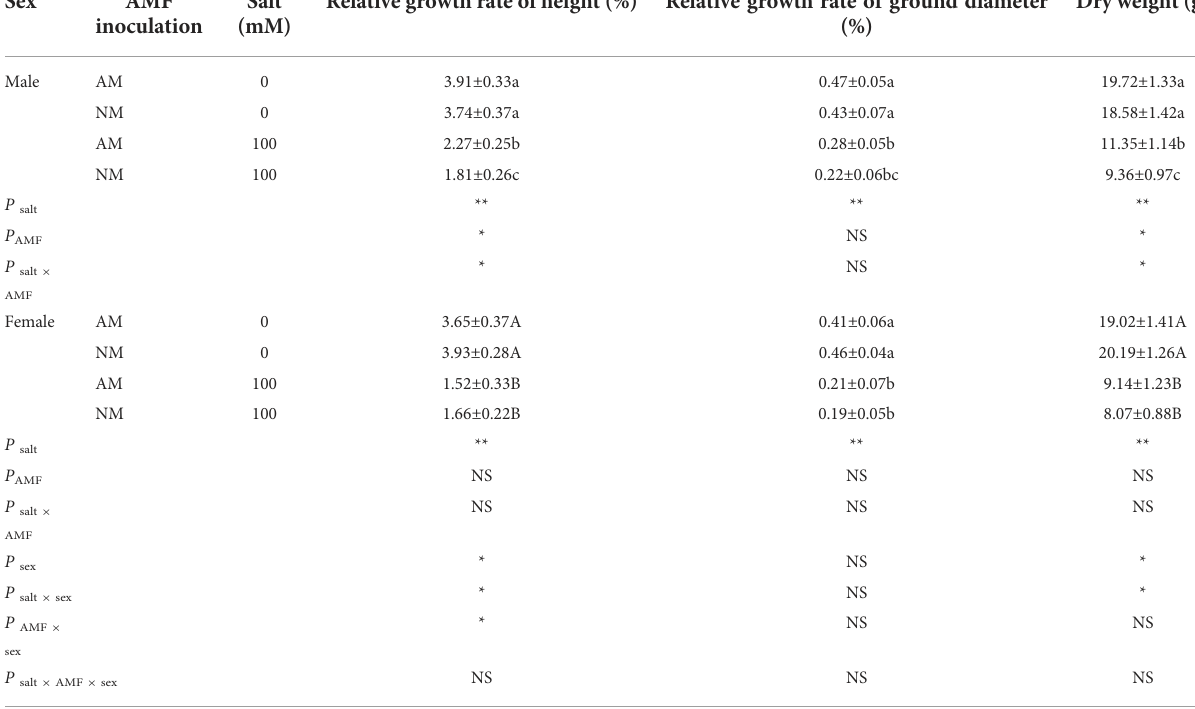
TABLE 3 Effects of AMF inoculation on growth status of P. euphratica females and males under different salt